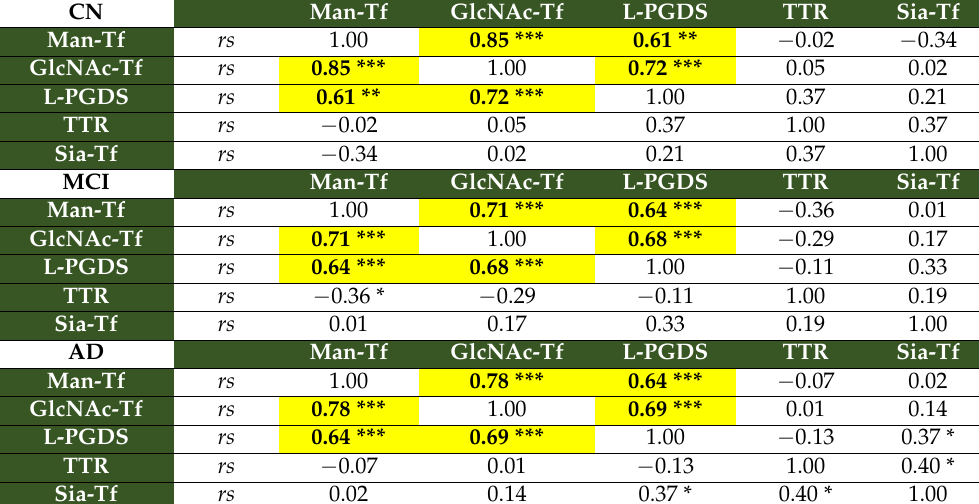
Table 1. Correlation coefficients among CSF major proteins in CN, MCI and AD. CN Man-Tf GlcNAc-Tf L-PGDS TTR Sia-Tf Man-Tf rs 1.00 0.85 ***